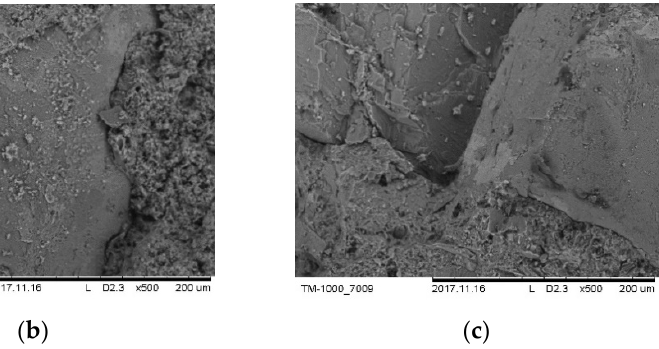
Figure 9. Microstructure of concretes made of: ( a ) dunite, ( b ) wehrlite, ( c ) troctolite.